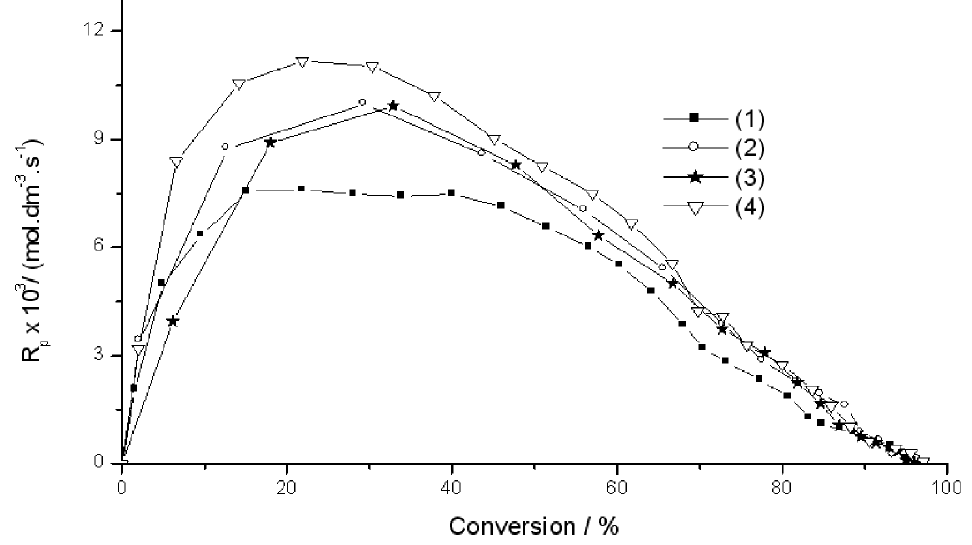
Fig. 2 Variation of the rate of polymerization in the inverse miniemulsion copolymerization of AAm with MBA concentration and